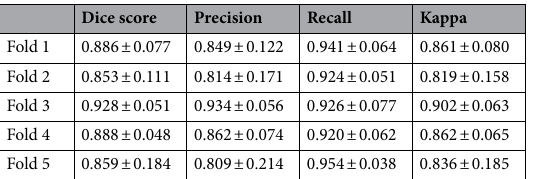
Table 1. Mean performance metrics of our method on fivefold cross validation.